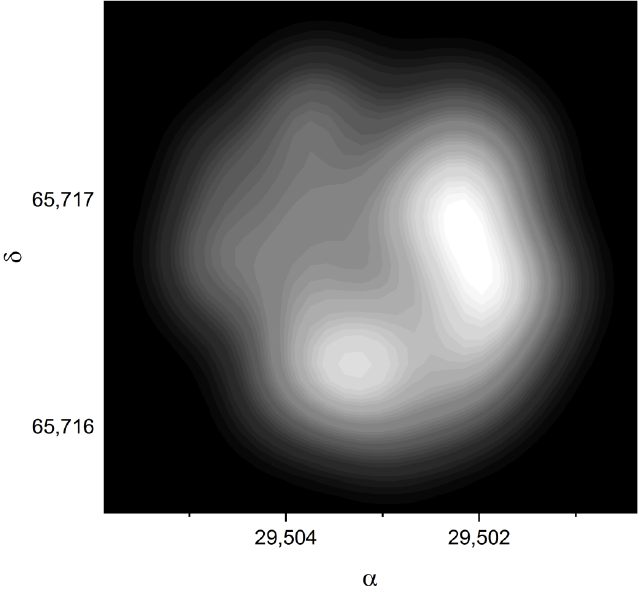
Figure 7. MASTER brightness distribution of the host galaxy region associated with FRB 180916.J0158+65. Analysis of such a large number of images is not possible without automation of the process. Our standard processing was usually intended to search for transients on a small